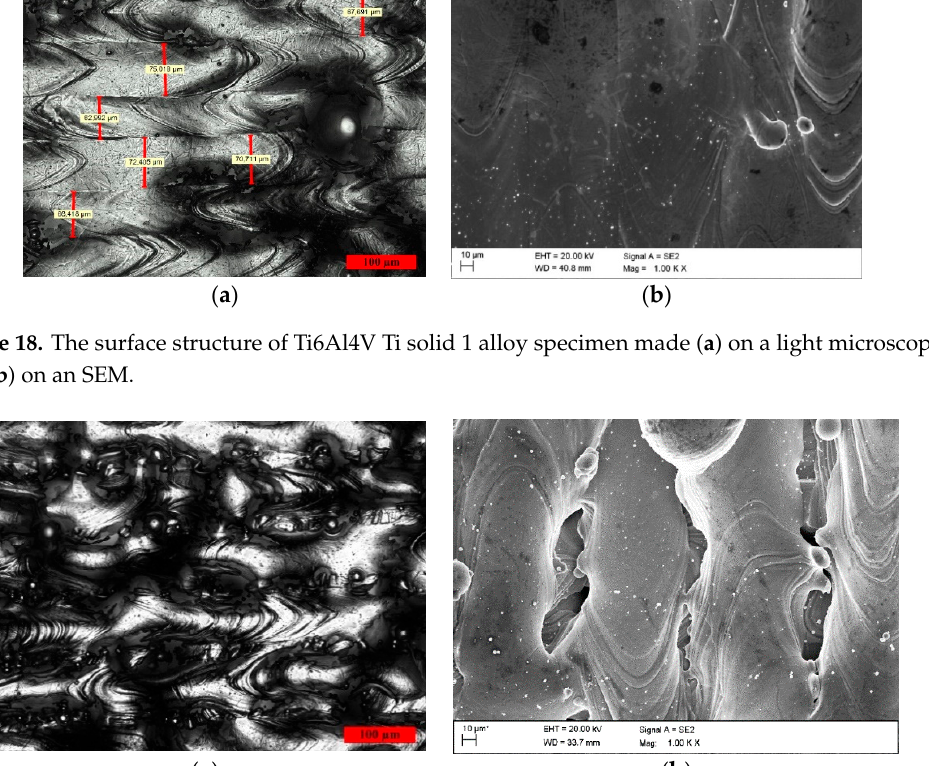
Figure 19. The surface structure of Ti6Al4V Ti solid 8 alloy specimens made ( a ) on a light microscope and ( b ) on an SEM.